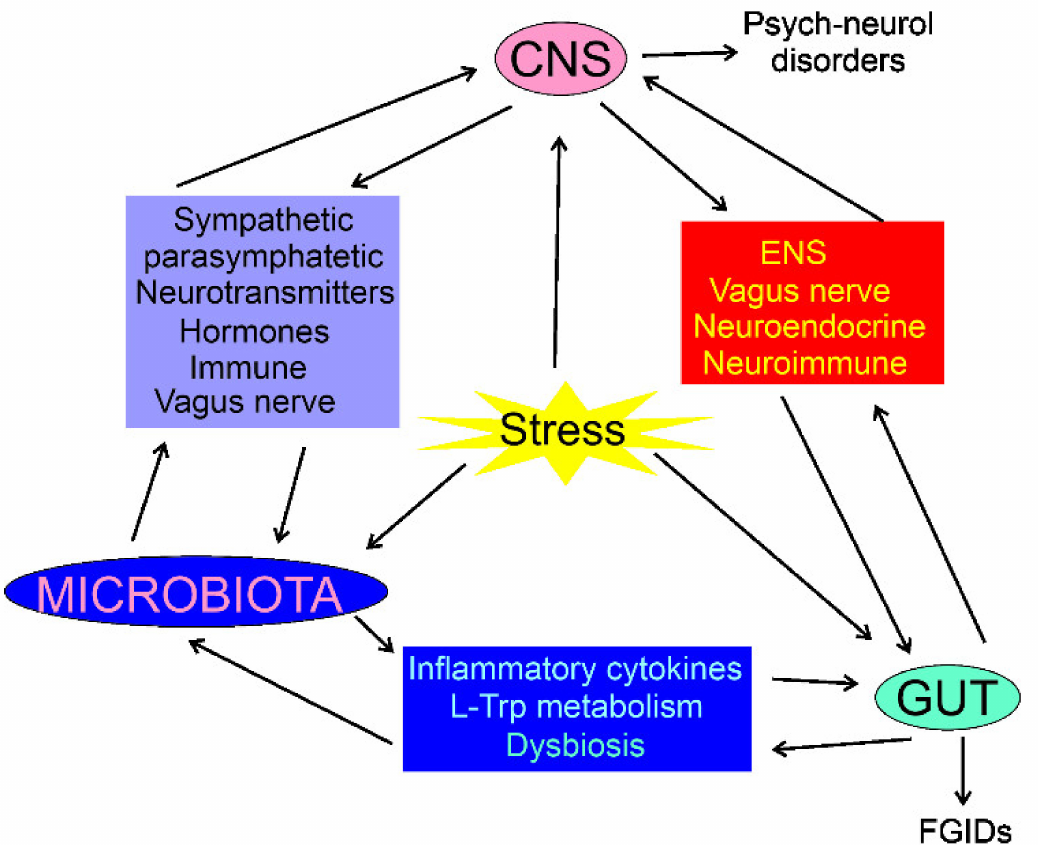
Figure 1. Interaction of the central nervous system (CNS), enteric nervous system (ENS), the gastrointestinal (GI) tract, and the gut microbiota in normal and stress conditions. In each case, the interaction is bidirectional and can be mediated by many factors; some of them are shown. Stress conditions may influence, directly or indirectly, CNS, gut, and microbiota, resulting in psychoneurological disorders and functional GI diseases (FGIDs). The stress may also result in organic GI or CNS diseases, which are not subjected to this